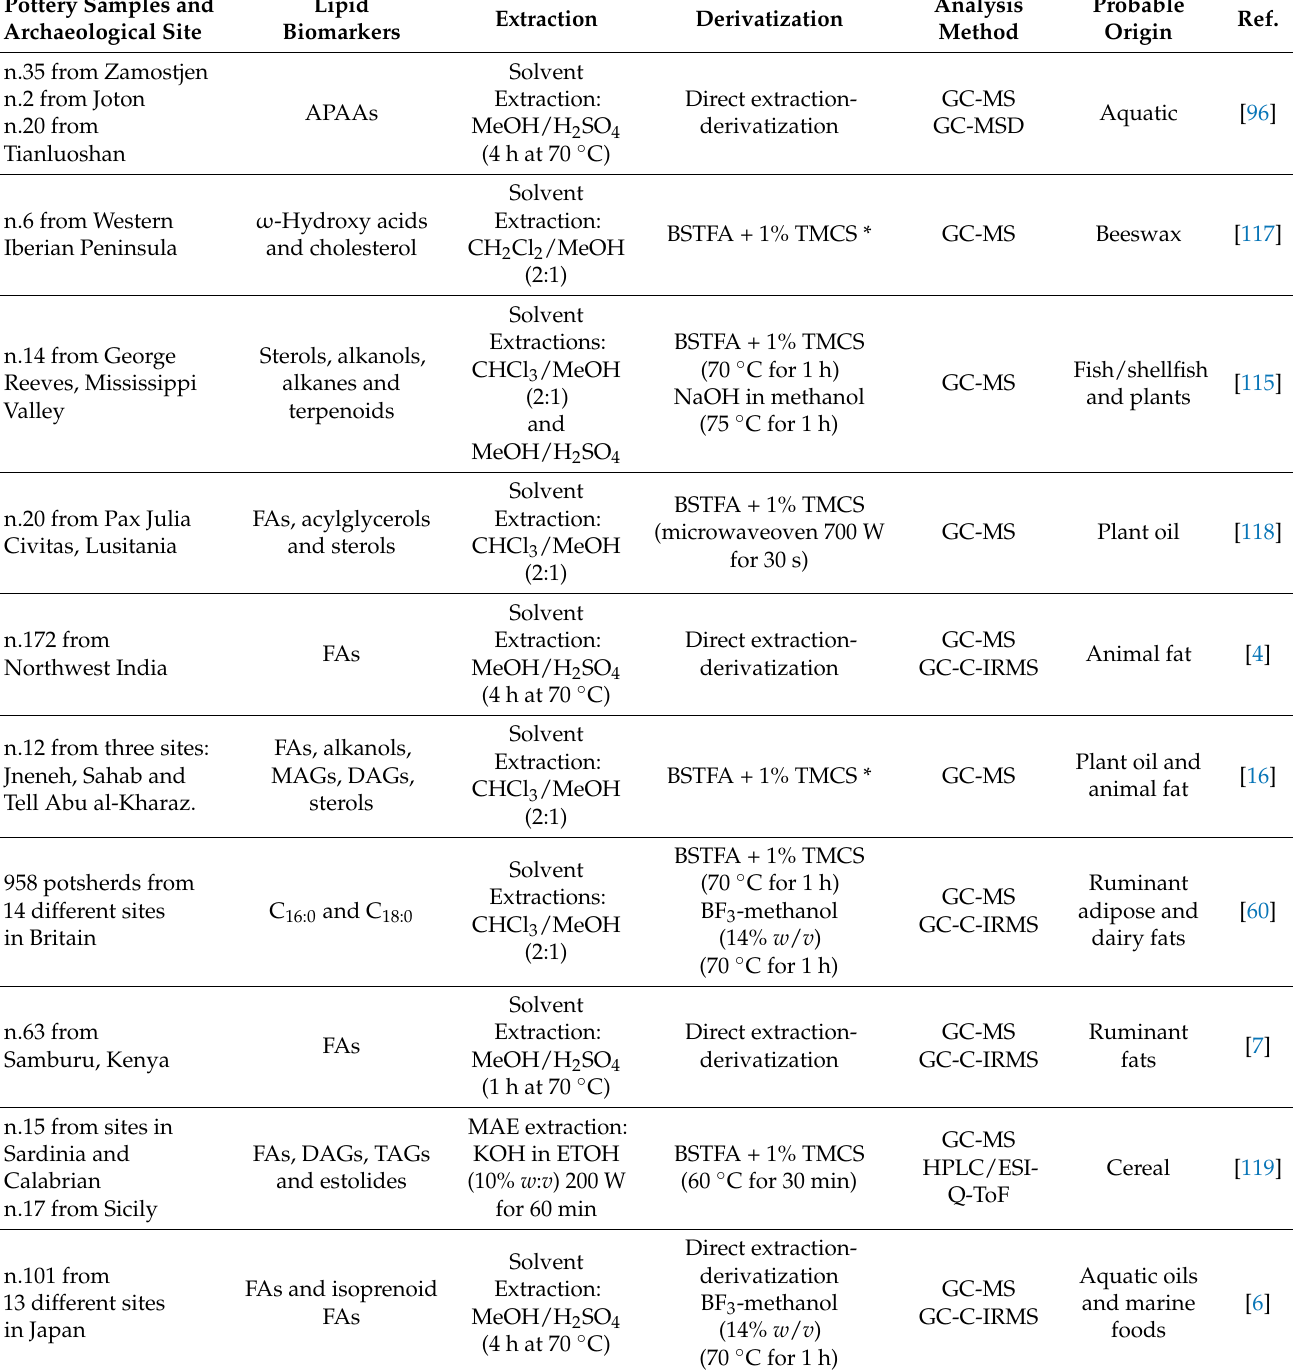
Table 1. Examples of lipid-based archaeological studies and relative analytical